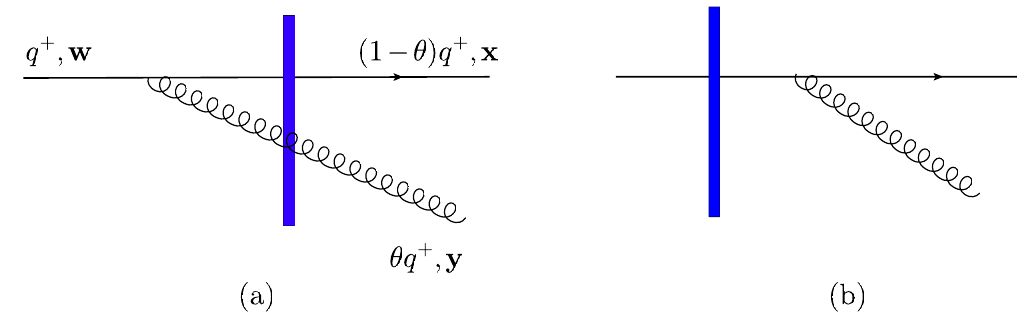
Figure 1 . The quark-gluon component of the outgoing wave-function for an incoming quark. There are two ways to insert the shockwave, before and after the gluons emission, represented in figure a and b, respectively.